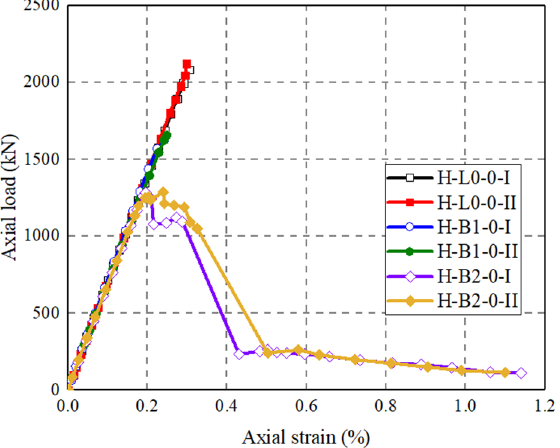
Figure 12. Effect of number of FRP grid layers on the axial load–strain